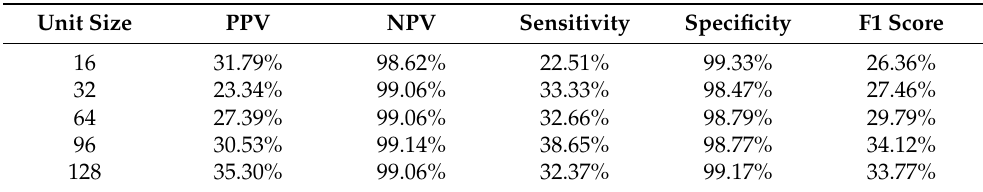
Table 7. Performance evaluation of the LSTM–GRU model according to the GRU and LSTM layer unit sizes. The highest PPV was 128 and highest NPV was 96. The highest sensitivity was 96 and highest specificity was 16. The highest F1 score was 96.